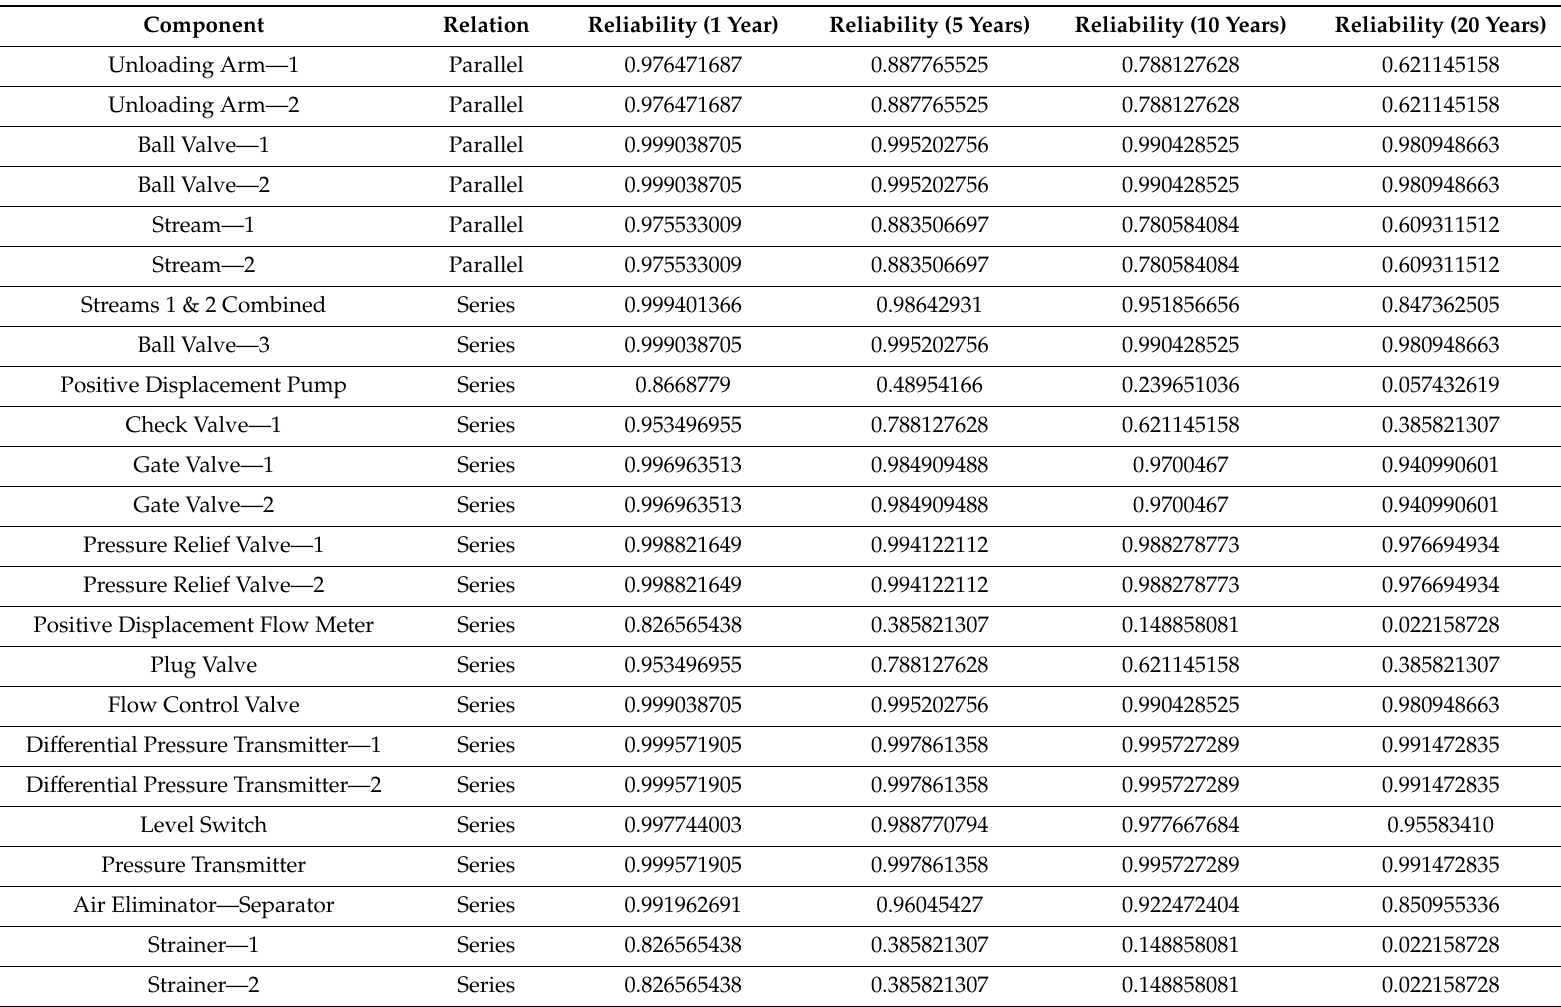
Table 5. Unloading system component reliability for di ff erent